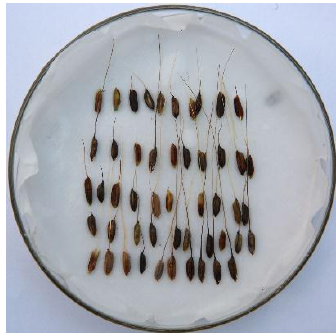
Figure A1. Germination of Chaling wild rice. The seeds were harvested in November 2017 and germinated under suitable conditions for seven days. The germination rate is zero.